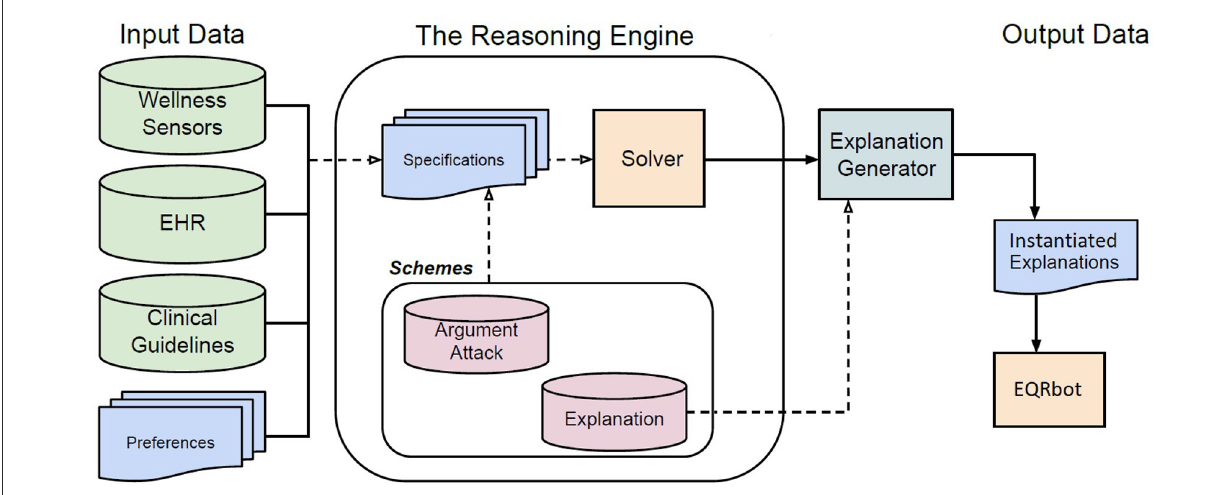
FIGURE1 Flow chart describing the internal architecture of the CONSULT cDSS. The input data is provided by different sources. The Schemes are templates for structuring and representing arguments, attacks and explanations. A formal language (i.e., first-order logic) is used to encode the knowledge, retrieved from the input data, in terms of Specifications that will then instantiate the attack and argument schemes subsequently computed in the resulting AF by the ASPARTIX ( Egly et al., 2008) Solver . The Explanation Generator [based on the sound and complete algorithm developed in Kökciyan et al. (2020)] constructs textual explanations for the recommendations according to explanation templates and the acceptable arguments produced by the Solver . The output will be stored in the Instantiated Explanations repository whose elements will feed the EQRbot , the